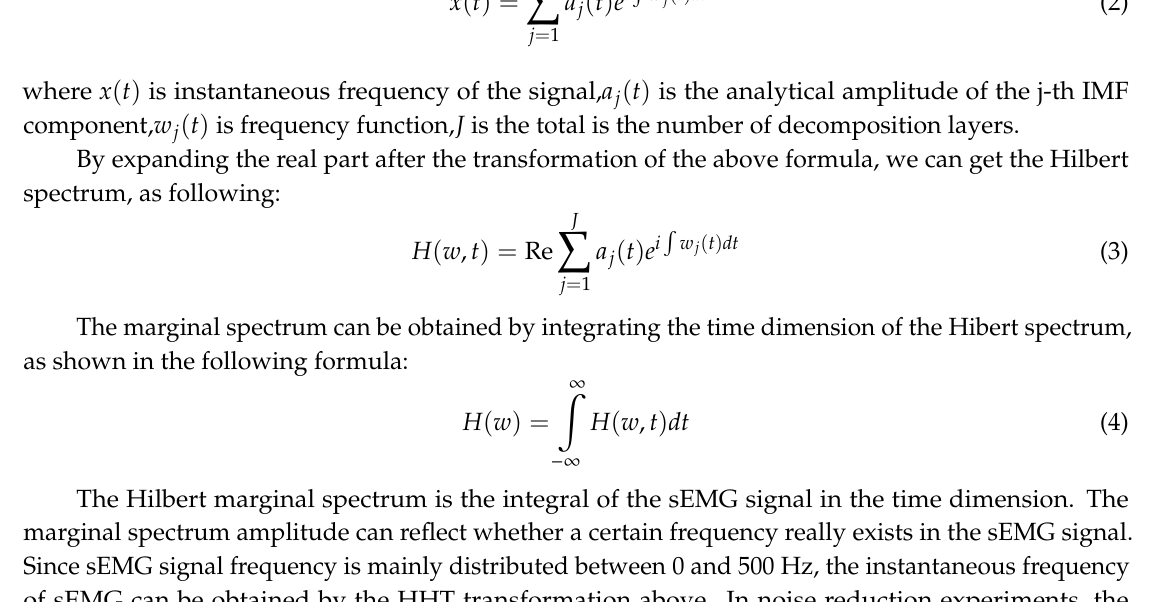
Figure 11. Five-layer decomposition of sEMG in the VM. The abscissa is the number of signal points, Figure 11. Five ‐ layer decomposition of sEMG in the VM. The abscissa is the number of signal and the ordinate is the signal amplitude points, and the ordinate is the signal amplitude